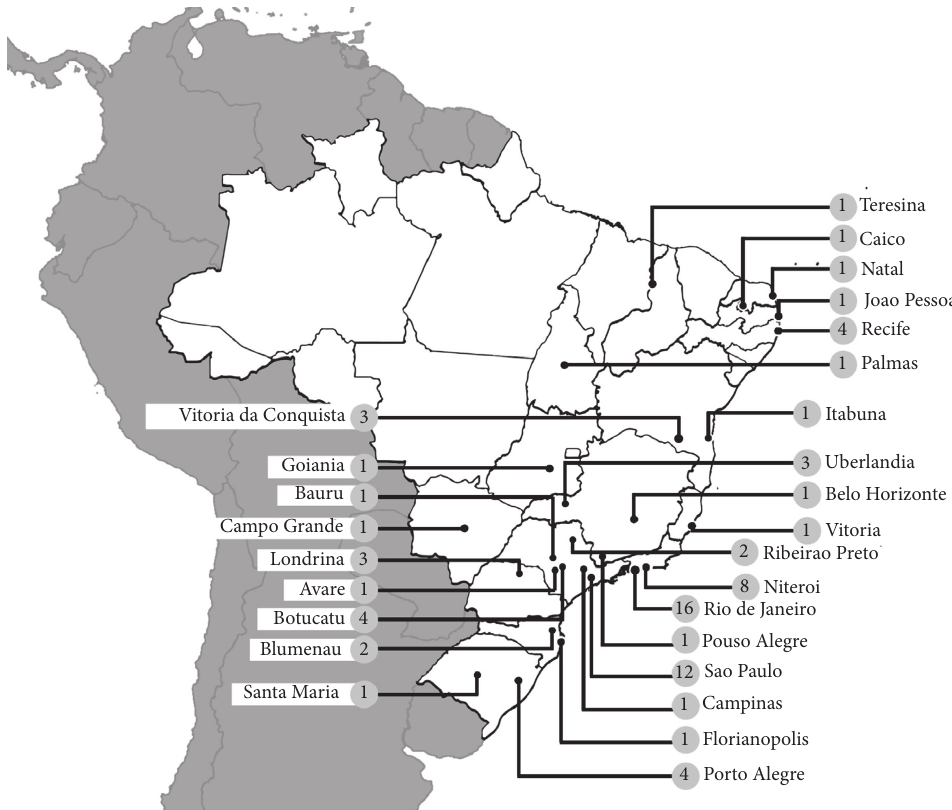
Figure 4: Map with georeference of MRSA reports showing the number of publications by isolation location during the 2010s.